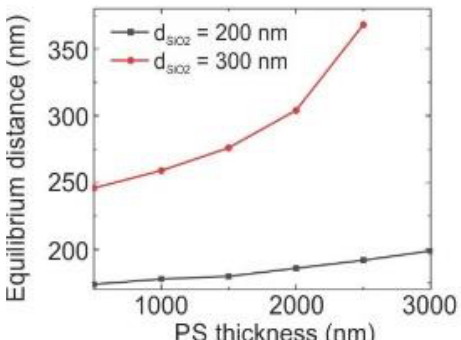
Fig. 2. Equilibrium distance as a function of the PS thickness slab in the levitating bilayer, with and (cid:6) (cid:11)(cid:12) = 30 nm fixed and = 200 nm (in back) and 300 nm (in red). setting (cid:6) (cid:13)(cid:14)(cid:15) (cid:16)